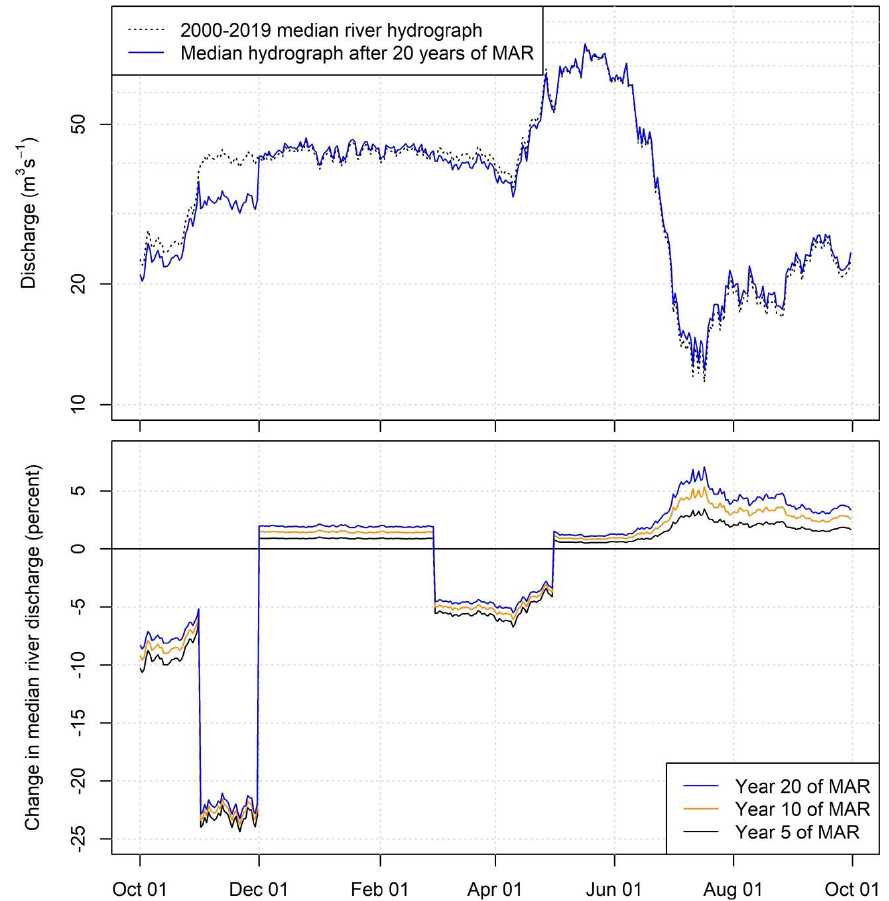
Figure 5. Net change in streamflow for annual scenario in which diversion for MAR from the study reach is 7.3 Mm 3 per month in each of March, April, and October, and 25.6 Mm 3 per month in November. Top panel shows median water-year hydrograph prior to and 20 years after initiation of annual MAR regime. Bottom panel shows percent change in streamflow 5, 10, and 20 years after initiation of annual MAR regime, respectively.